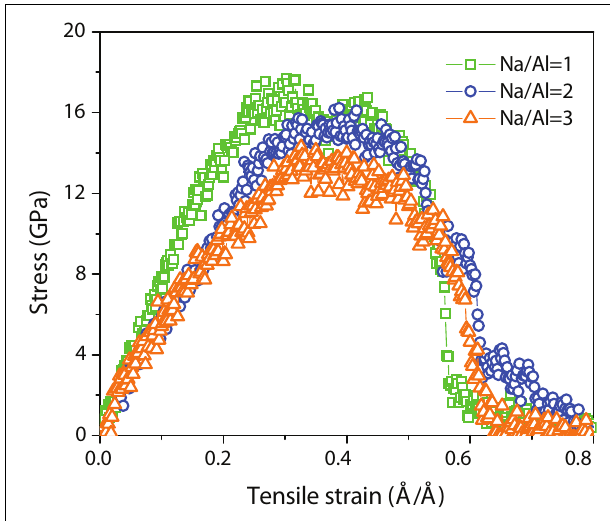
FIGURE 4 | Stress–strain relation for NASH gel with a ratio of 1, 2, and 3, stretched along the X direction with a strain rate of 0.08/ps.